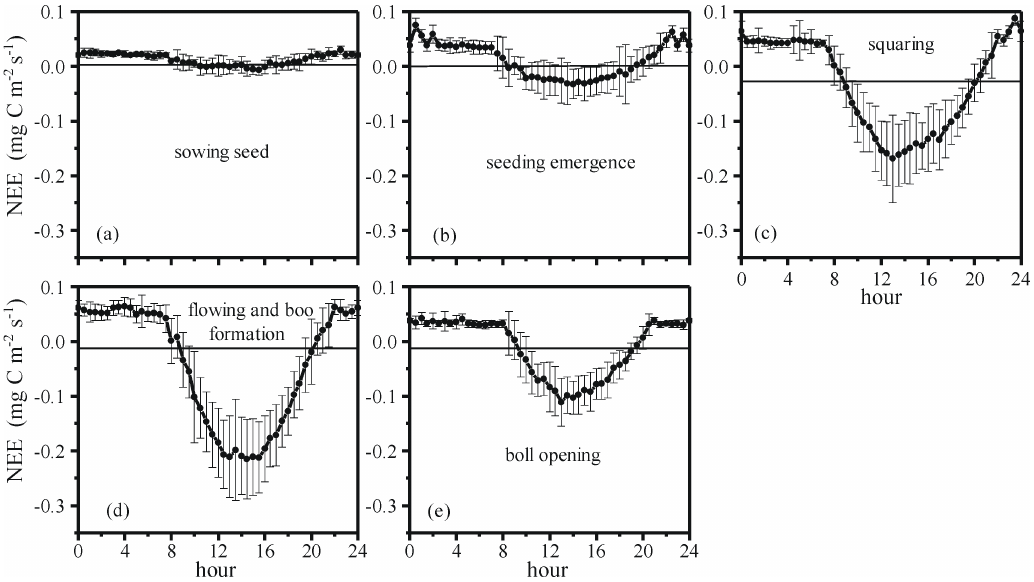
Fig 2. Average diurnal profiles of NEE (net ecosystem exchange) for five growth stages and mean values of the diurnal variation in NEE for each growth stages. The vertical bars represent the standard deviation of the mean values.